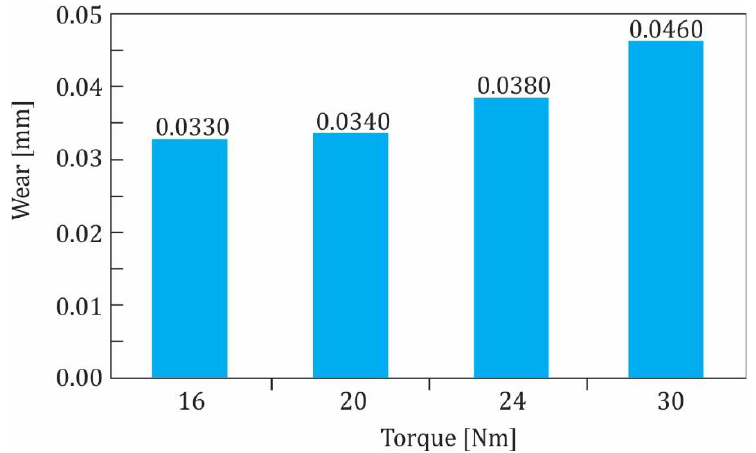
Figure 10. Wear of POM-gears without coating at different torques.